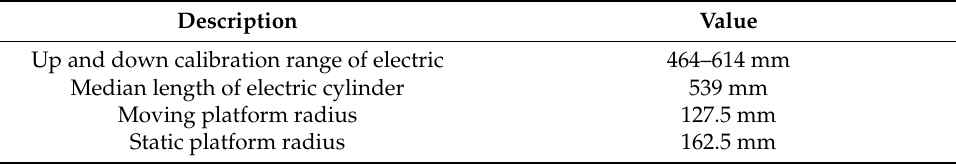
Table 2. Electronic system parameter list.